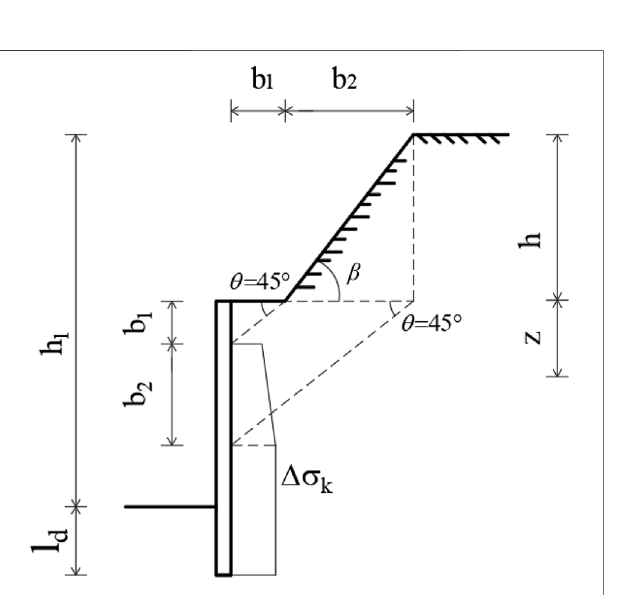
Frontiers in Earth Science |